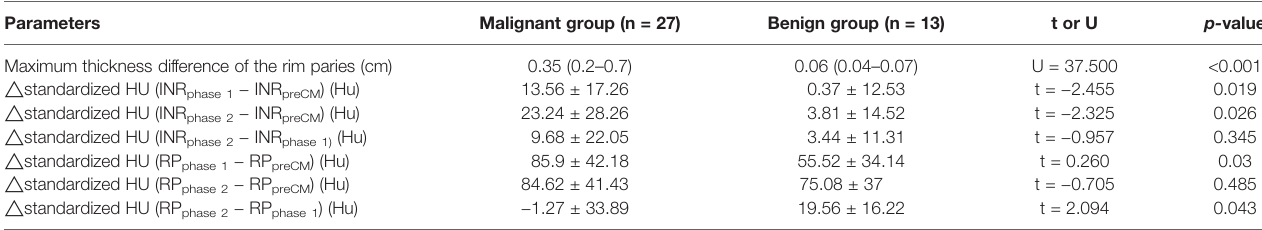
TABLE 3 | Comparison of the quantitative enhancement parameters between malignant and benign groups by CE-CBBCT. Parameters Maximum thickness difference of the rim paries